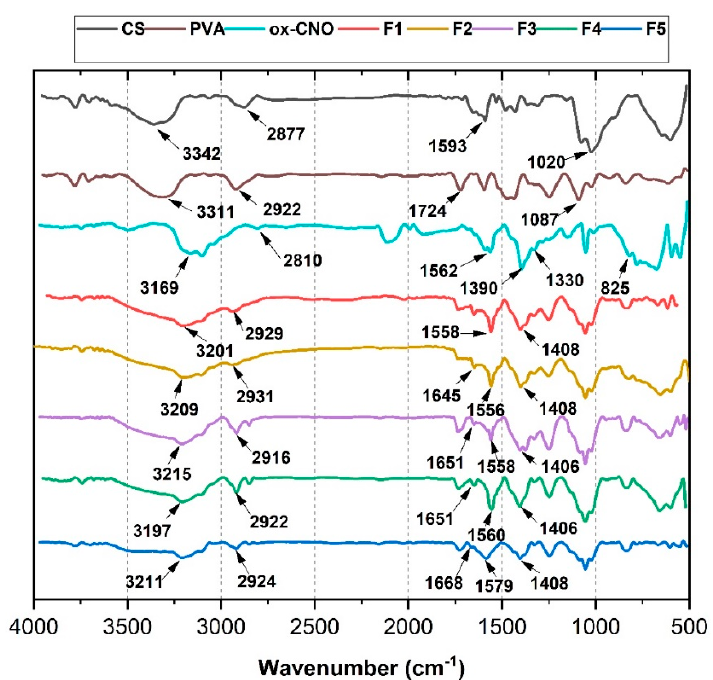
Figure 2. Attenuated total reflectance Fourier-transform infrared spectroscopy (ATR-FTIR) of / poly(vinyl alcohol) (PVA) / ox-CNO films. Formulations: F1 (CS:PVA:ox-CNO chitosan (CS)/poly(vinyl alcohol) (PVA)/ox-CNO films. Formulations: F1 (CS:PVA:ox-CNO 30:70:0); chitosan (CS)